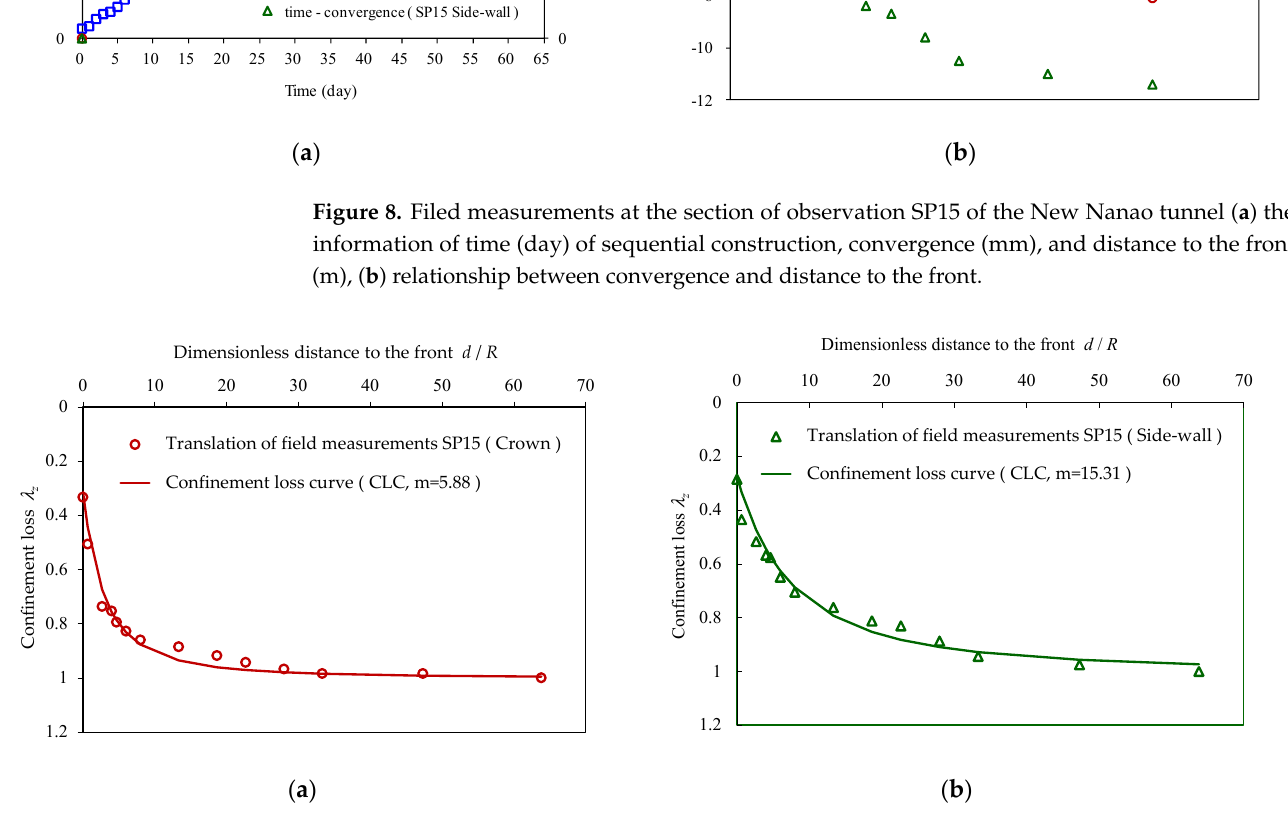
Figure 9. Relationship between confinement loss and dimensionless distance to the front at the section of observation SP15 of the New Nanao tunnel ( a ) at crown, ( b ) at side-wall.